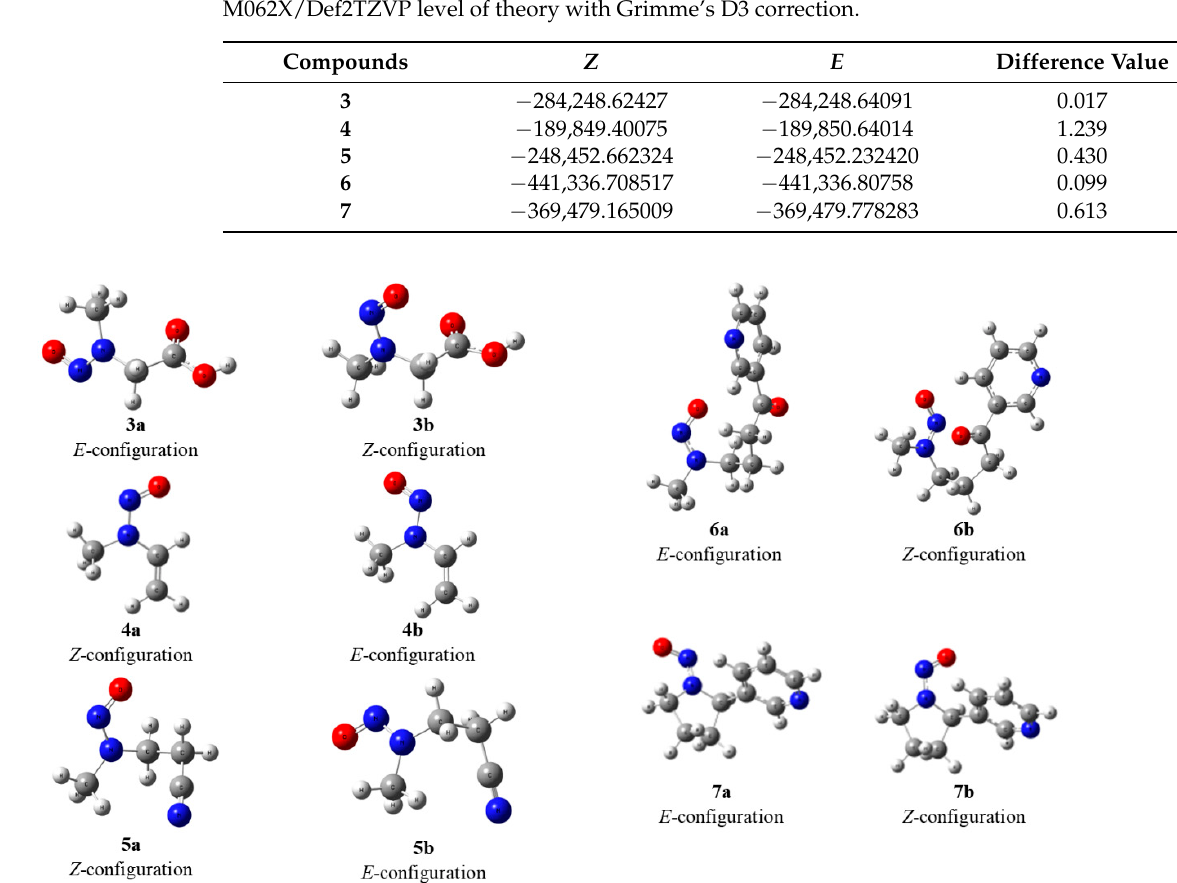
Table 6. The Gibbs free energy values (G, Kcal/mol) of Z / E isomers for compounds 3 – 7 at the